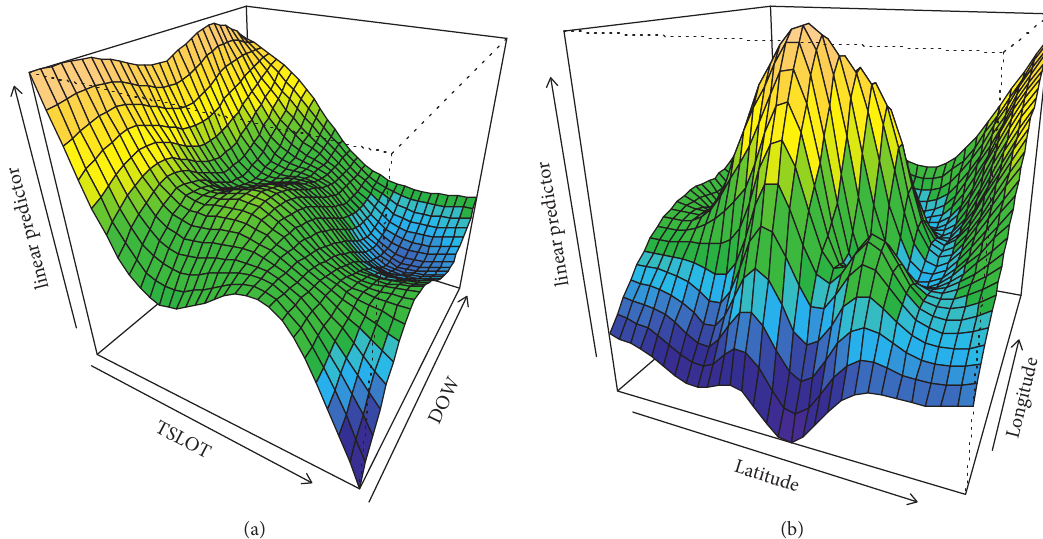
Figure 7: Visualization of fitted taxi vacant time with temporal and spatial interactions. (a) Day of the week and hourly slots (DOW, TSLOT). (b) Longitude and latitude (longitude, latitude).